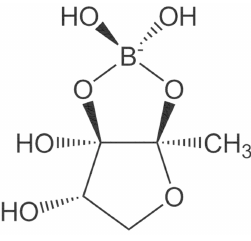
Figure 4. Boron structure.